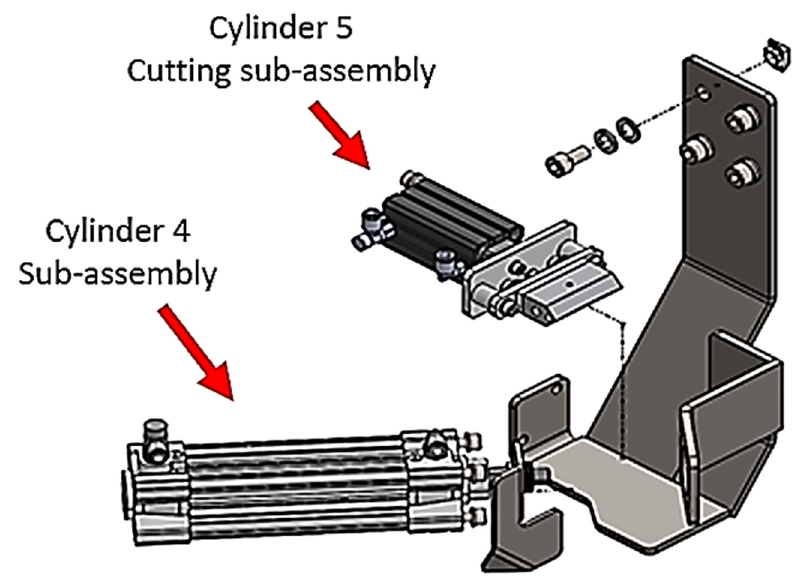
Figure 21. Handle cut assembly’s exploded view.